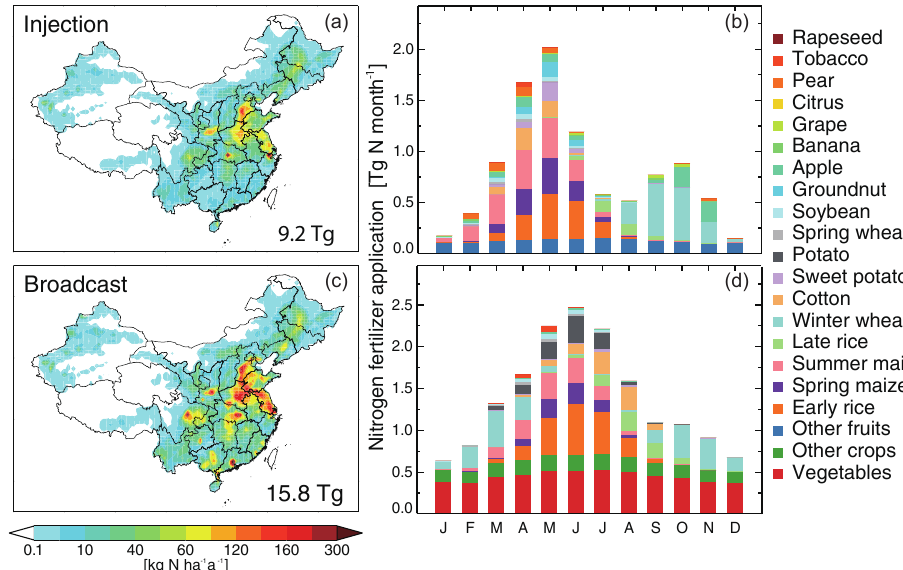
Figure 5. Fertilizer application through injection (a, b) and broadcast (c, d) techniques in China for 2008. Panels (a, c) show annual total fertilizer application at the 1 / 2 ◦ × 2 / 3 ◦ model resolution with the annual totals given inset. Panels (b, d) show monthly fertilizer application amounts over China for the 18 crop types.